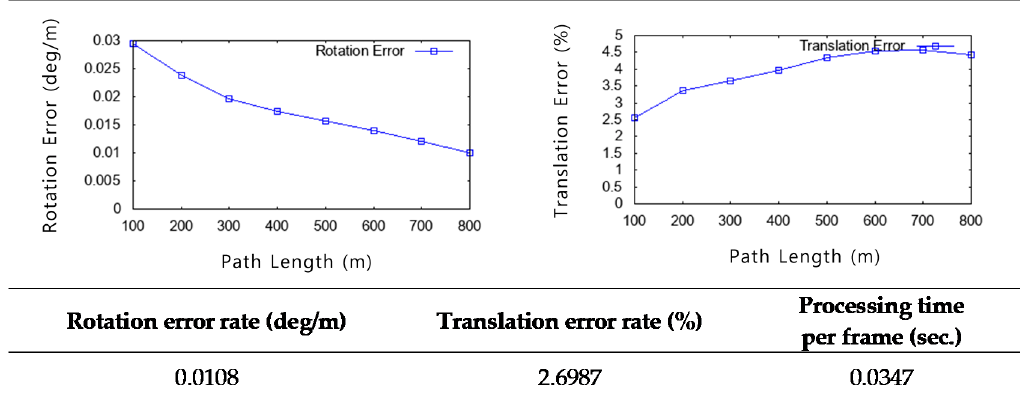
Figure 23. Graph of error over mileage for sequence 09.